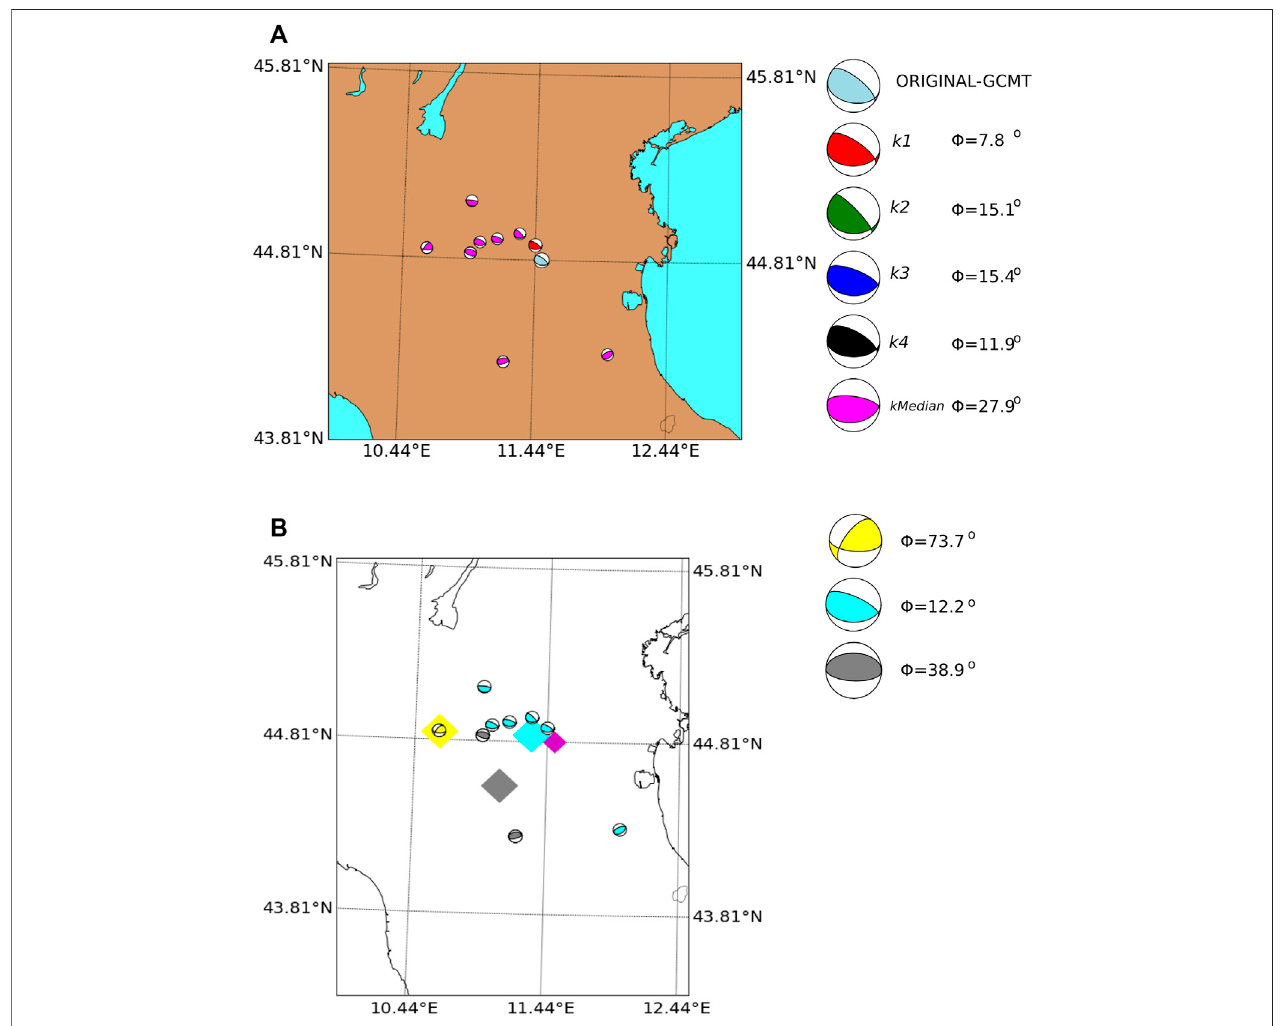
FIGURE 12 | Same as Figure 8 for an M w = 5.2 Italian earthquake (see Table 3